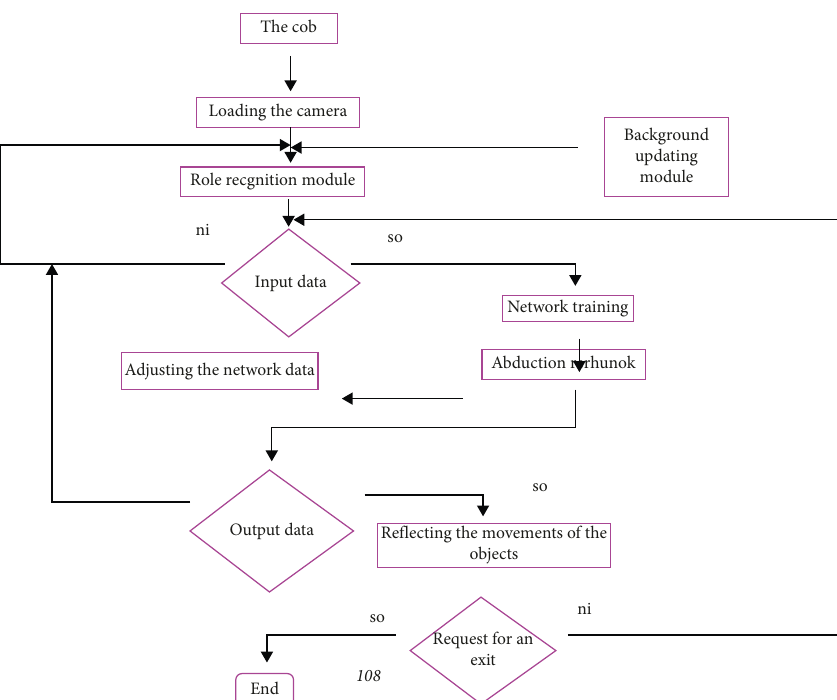
Figure 2: Image recognition